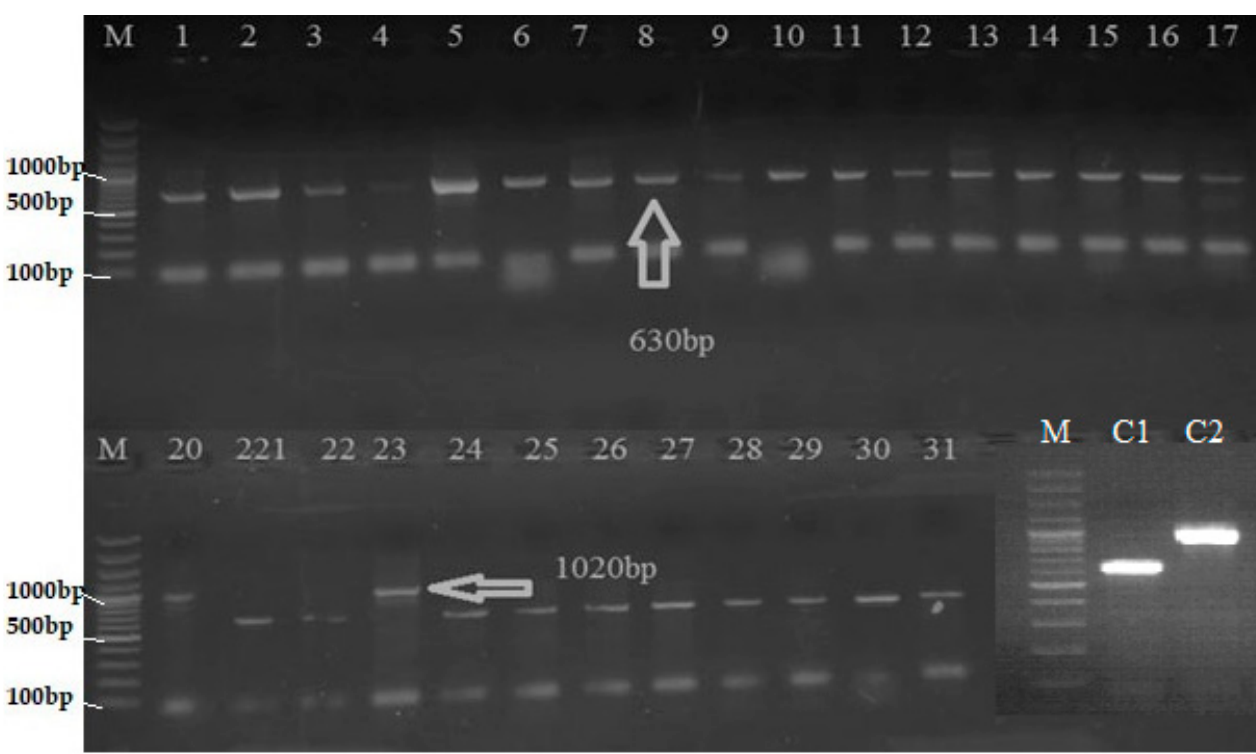
Figure 1. PCR analysis of RILs of rice for the presence of Xa21 gene (Arrow showing 1020 bp bands of Xa -21 gene). M = 100 bp DNA ladder, C1 = Basmati-385, C2 = IRBB59, line 1–31 = Selected geno- types.